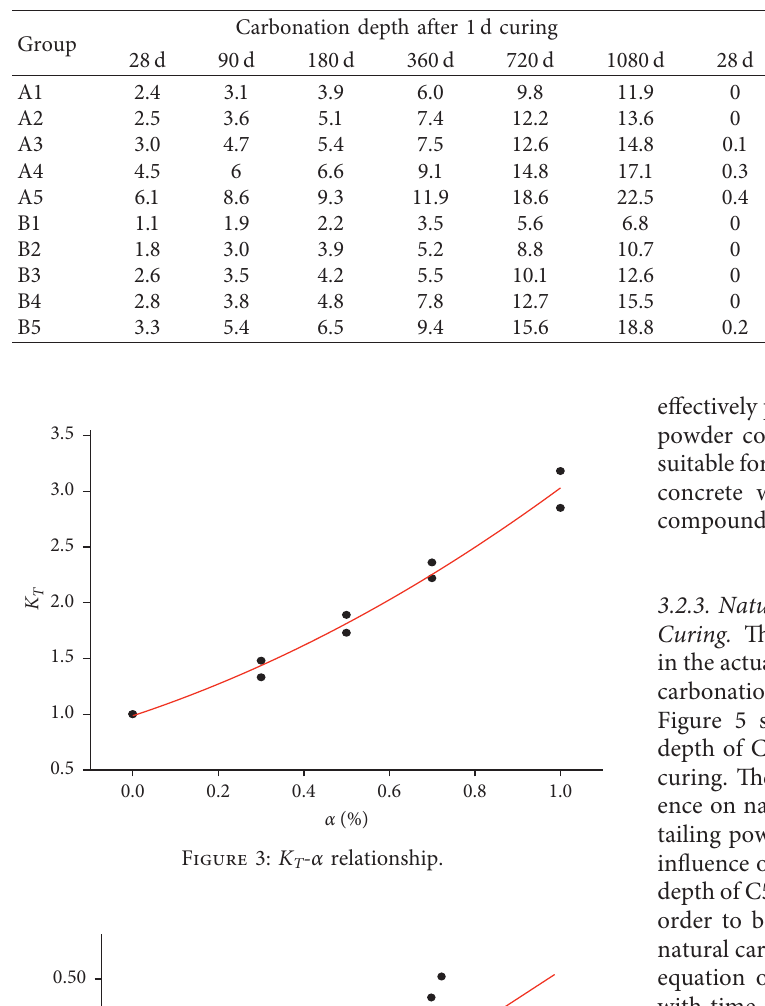
Table 5: Natural carbonization depth of concrete (mm).